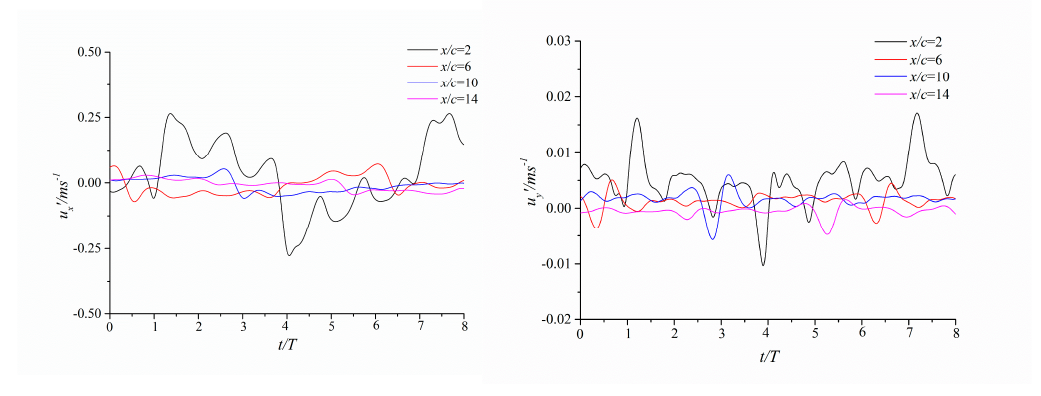
Figure 8. Instantaneous velocity fluctuation at y / Ls = 0.25 over 8 passing cycle: ( a ) f = 20 Hz ( b ) f = 30 Hz ( c ) f = 40 Hz.